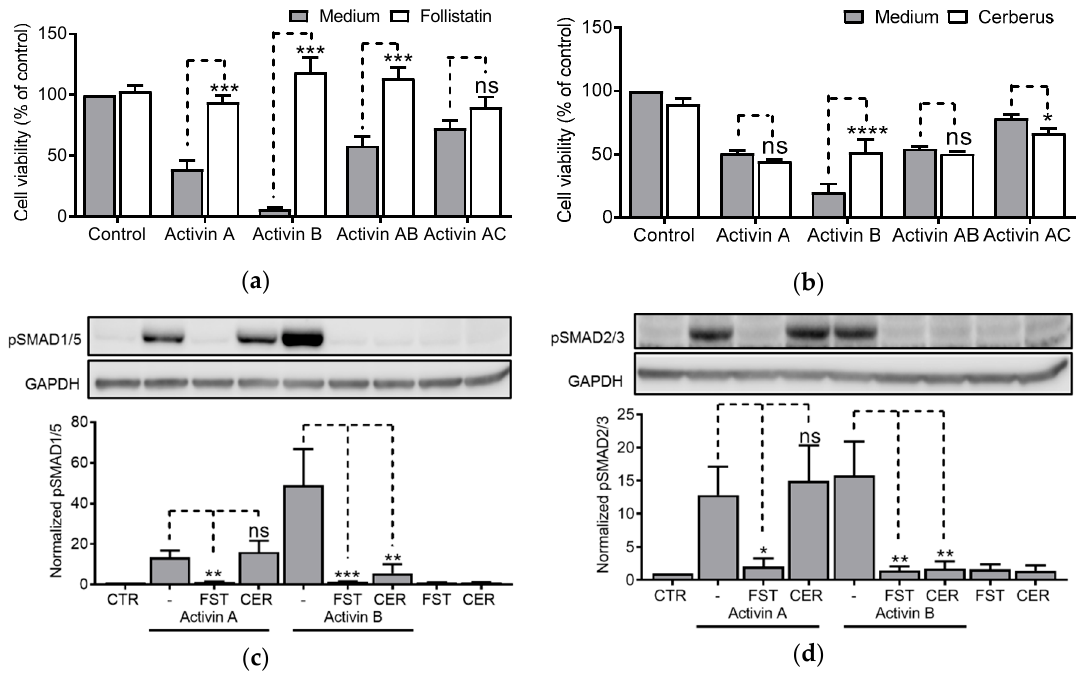
Figure 6. Antagonism of activins by follistatin and cerberus. IH-1 myeloma cells were treated for three days with activin A or activin AC (20 ng / mL), activin B (4 ng / mL) or activin AB (5 ng / mL) in combination with either ( a ) follistatin (1 µ g / mL) or ( b ) cerberus (4 µ g / mL) before cell viability was measured using CellTiter Glo. Results are plotted relative to the control. The phosphorylation status of SMAD1 / 5 ( c ) and SMAD2 / 3 ( d ) was measured by western blot. IH-1 myeloma cells were treated for one hour with activin A (20 ng / mL) or activin B (50 ng / mL) with or without follistatin (1 µ g / mL) or cerberus (4 µ g / mL). Representative experiments are shown (upper panels) and relative activation was calculated based on signal intensities of the SMADs and GAPDH for normalization (lower panels). The graphs ( a – c ) represent mean ± s.e.m. of n = 3 independent experiments. Two-way ANOVA and Bonferroni’s multiple comparisons test were performed (* p ≤ 0.05, ** p ≤ 0.01, *** p ≤ 0.001, **** p ≤ 0.0001, ns (not significant) p > 0.05).